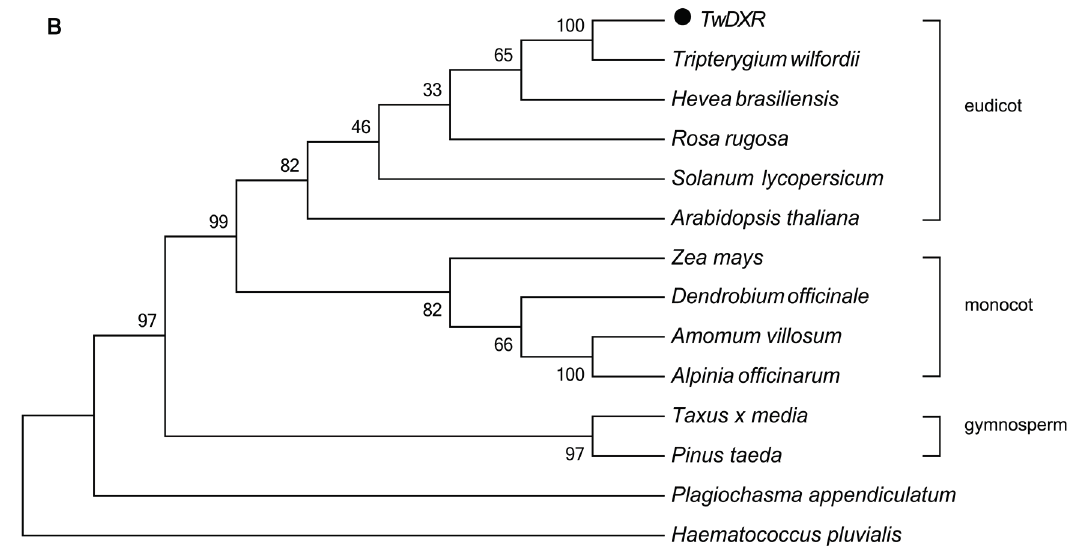
Figure 3. Phylogenetic analysis of the amino acid sequences of DXSs ( A ) and DXRs ( B